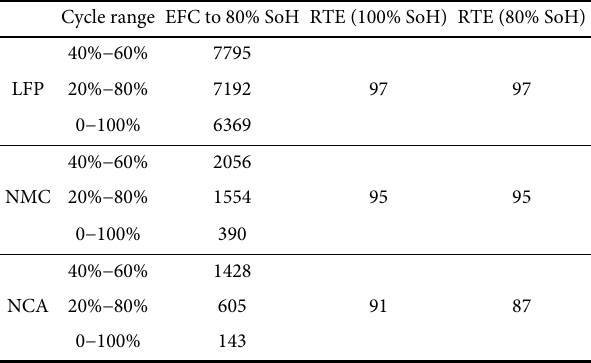
Table 2 EFC and RTE of three lithium battery technologies at different cycling conditions